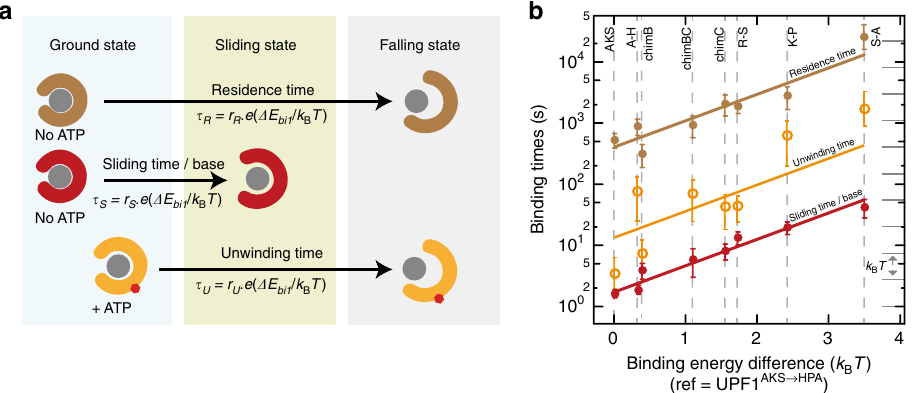
Fig. 4 Mechanistic model describing helicase grip in different energy states. a Schematic representation of the three observable helicase states (see text). Gray circle represents NA. Colored clips represent helicases clamping NA more or less tightly. b Binding and sliding times plot versus increasing binding energy differences represented with a logarithmic scale in y . For each helicase i , the sliding time τ S , the unwinding time τ U and the falling time τ R are drawn in logarithmic scale against the binding energy difference Δ E bi1 = E bi − E b1 measured in units of k B T ( E b1 corresponds to UPF1 AKS → HPA binding energy). Each helicase has its three representative points located at the same abscissa. Full lines are exponentials predicted by Supplementary Equation 3 (Supplementary Note). Distance between the lines re fl ects the energy difference between these three states. Error bars indicate standard